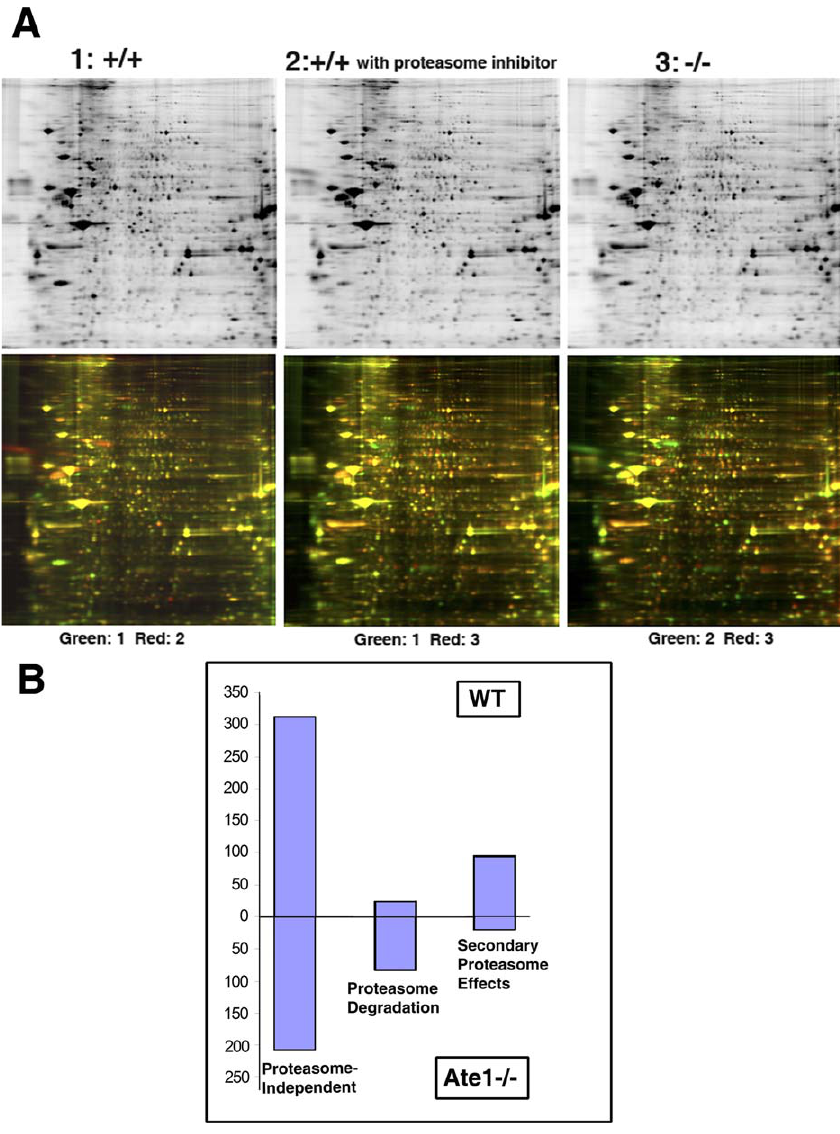
Figure 1. 2D Gel Comparison of the Effects of Arginylation and Proteasome Degradation (A) Top row: individual images of 10% 2D gels (pH range 3.5–10 increases left to right) of whole cell extracts from wild-type ( þ / þ , WT) cells labeled with Cy2 (1, left), WT cells treated with proteasome inhibitor labeled with Cy3 (2, middle), and arginylation-free Ate1 (cid:2) / (cid:2) cells labeled with Cy5 (3, right). Bottom row: pairwise comparison of the gels shown on top in different fluorescence channels. Colors were altered to red and green to allow better visual comparison. (B) Quantification of the number of spots up- or down-regulated in response to each treatment. See also Table S4. Proteins identified in the most abundant spots from Coomassie-stained gels obtained under similar conditions are listed in Tables S1 (reflecting the comparison between gels 1 and 3) and S2 (reflecting the comparison between gels 1 and 2). See explanations in the text.